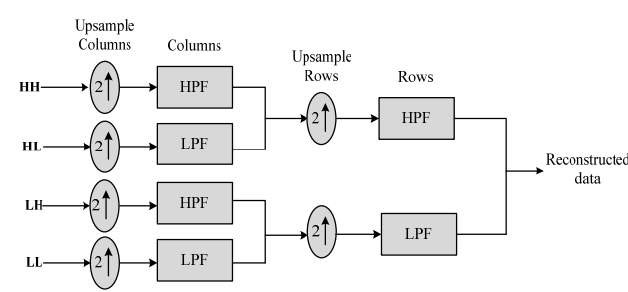
Figure 5. Block diagram of 2D Inverse